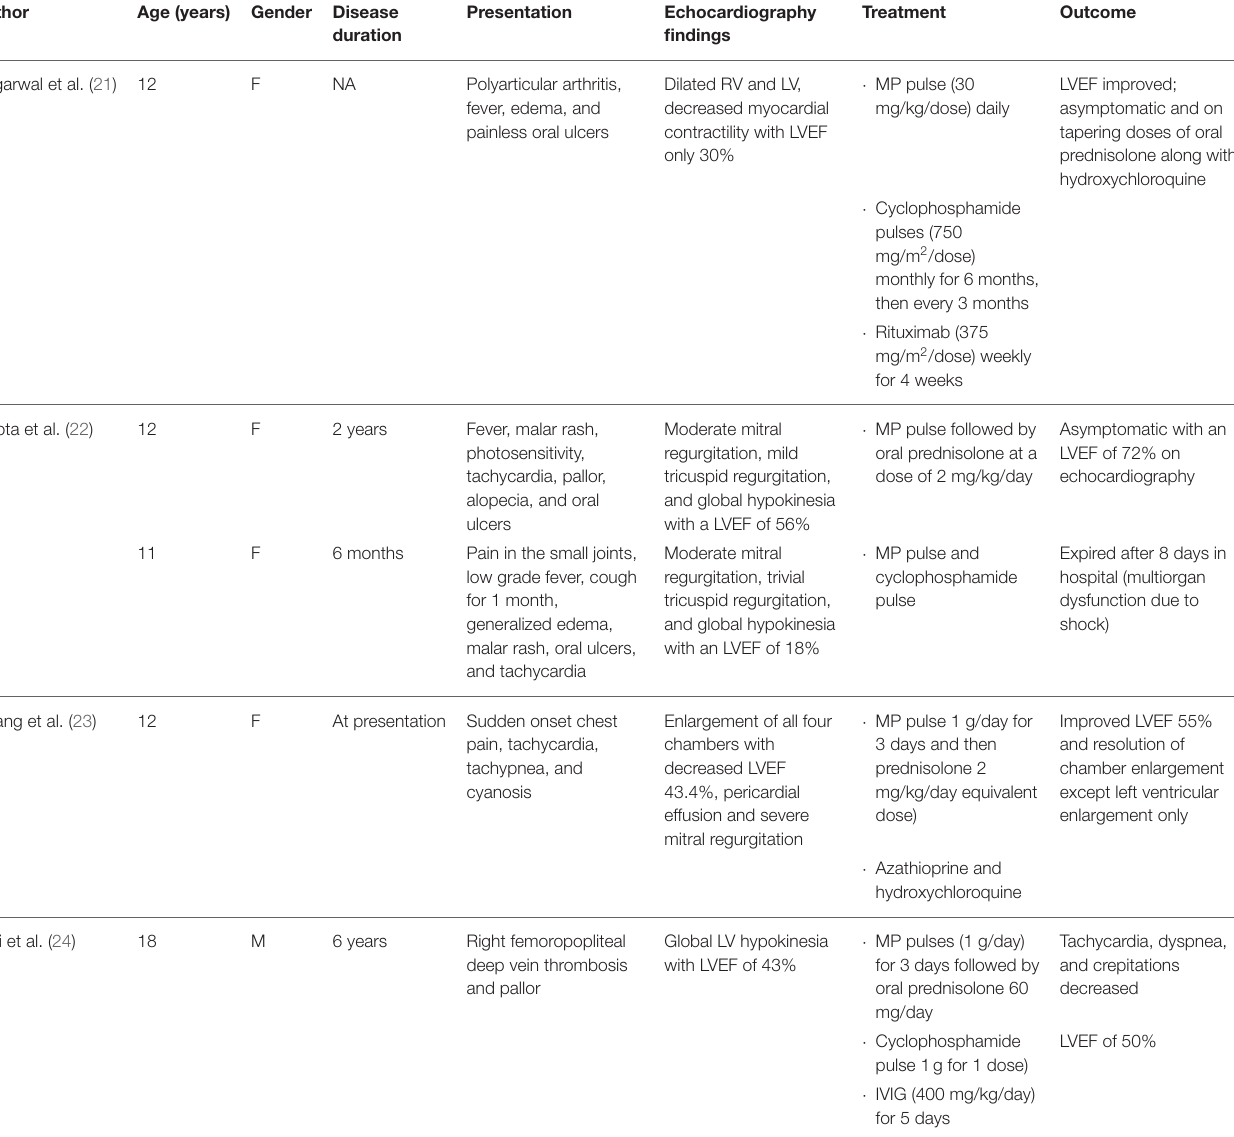
TABLE 1 | Previous case reports of myocarditis in patients with pediatric